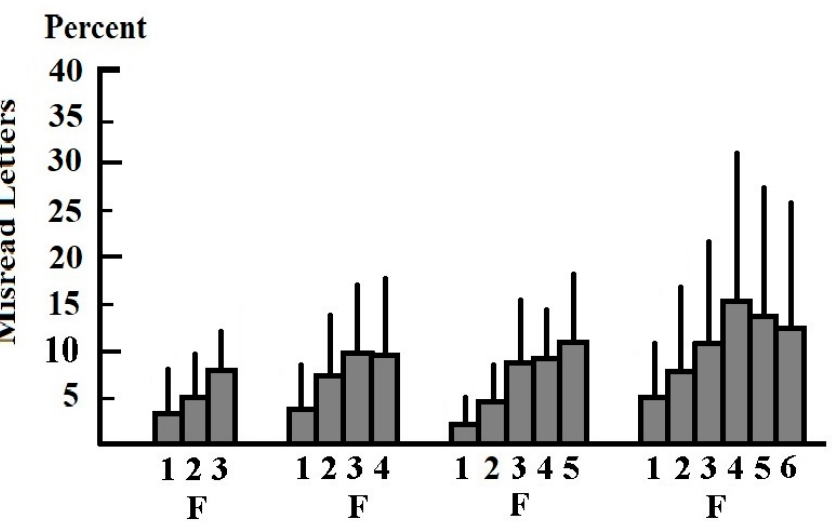
Figure 1. Percentage of incorrectly read letters in 3-letter, 4-letter, 5-letter, and 6-letter pseudowords according to their location in the words. Vertical bars above columns indicate standard deviation. The letters were either omitted, replaced by other letters, or shifted to an incorrect position. Numbers denote the letters in the pseudowords from left to right. F denotes the letter that occurred at the fixation point. The rate of incorrectly read letters increased from left to right. The rate of reading mistakes was lowest for the first letter. In 3-letter and 4-letter pseudowords it was highest for the third letter, in 5-letter pseudowords for the fifth letter, and in 6-letter pseudowords for the fourth letter.